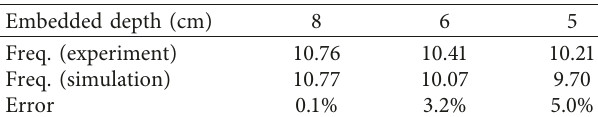
Figure 9: Simulation results of the scour process. (a) Displacement and flow velocity. (b) Comparison under different embedded depths. Table 3: Frequency comparison between governing variables ex- periment and simulation.